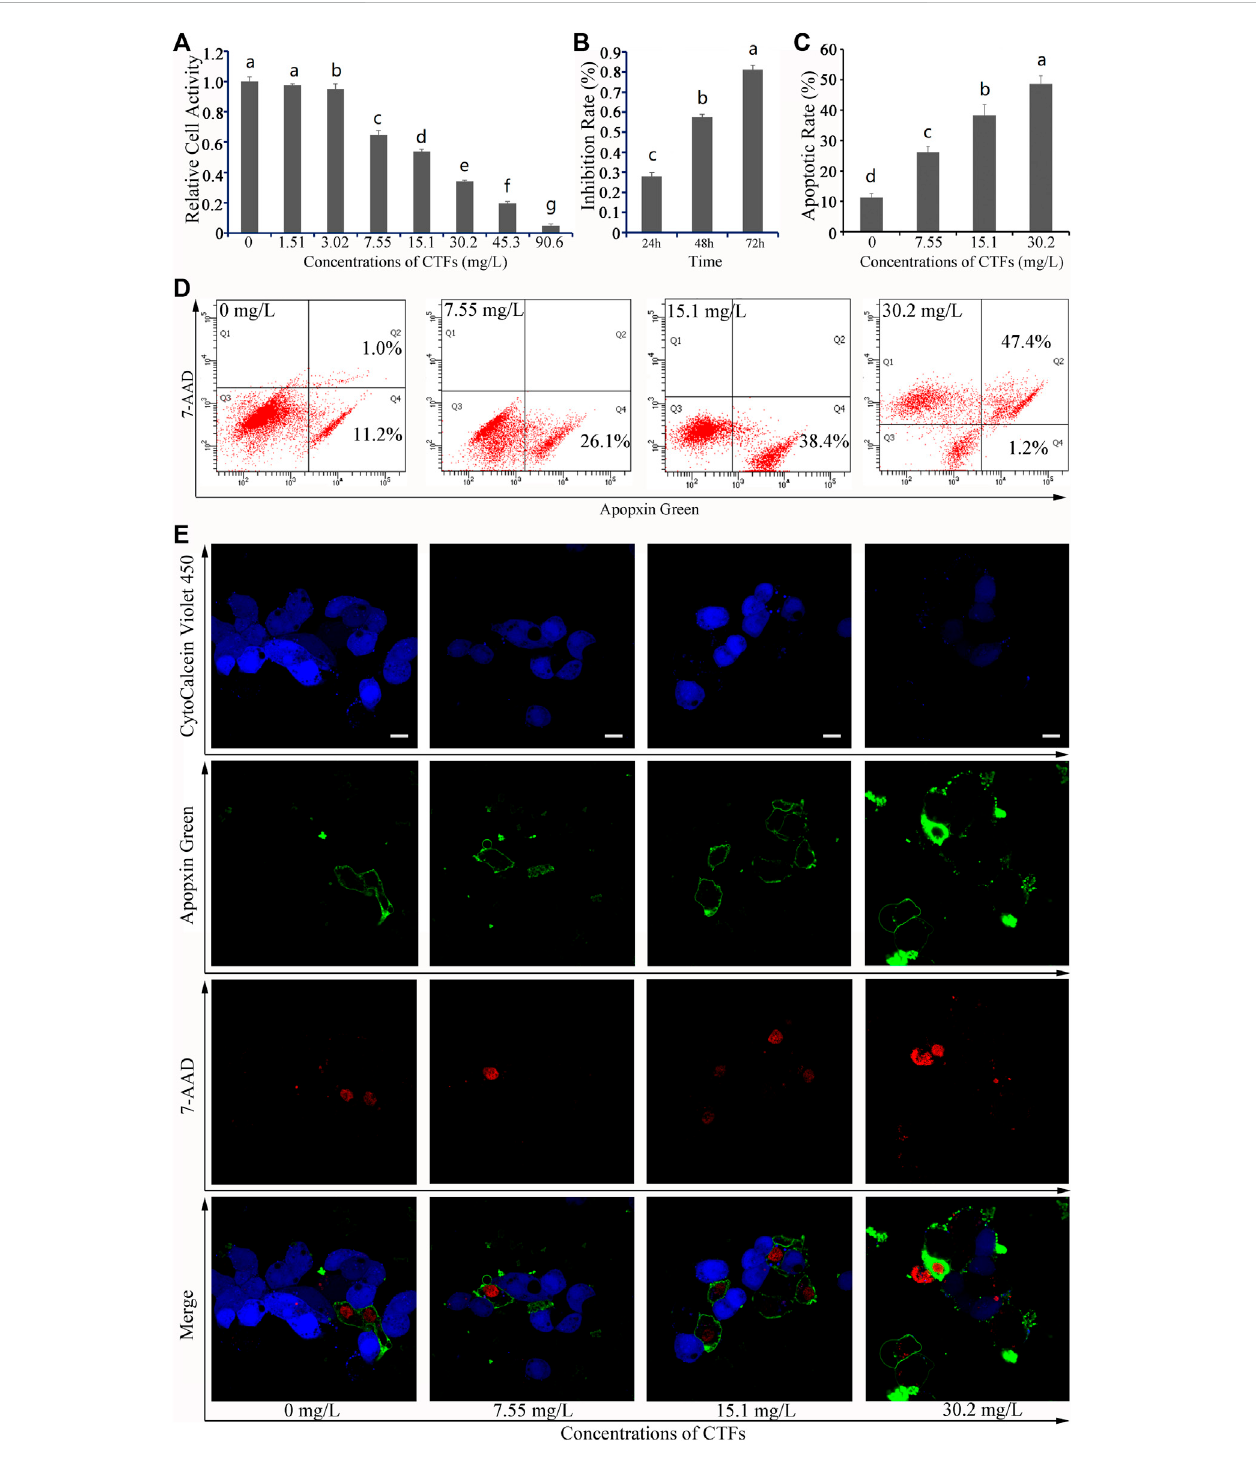
FIGURE 1 Effects of Cyclocarya paliurus total fl avonoids (CTFs) on HepG2 cells. (A) Relative cell activity, (B) Inhibition rate, and (C) Apoptotic rate. Data are expressed as the mean ± SEM ( n = 3). Different small letters indicate extremely signi fi cant differences between two treatments ( p < 0.01). (D) Representative FACS plots of cells treated with different concentrations of CTFs and stained with Apopxin Green and 7-AAD to identify apoptotic cells in the early and late stages, respectively.From left to right, theconcentration ofCTFswas 0 μ g/mL, 7.55 μ g/mL, 15.1 μ g/mL, and 30.2 μ g/mL. Data are representative offour independent experiments. (E) Representative CLSM images of HepG2 cells treated with different concentrations of CTFs and stained with CytoCalcein Violet 450 (in blue color, representing live cells), Apopxin Green (in green color), 7-AAD (in red color). From left to right, the concentration of CTFs was 0 μ